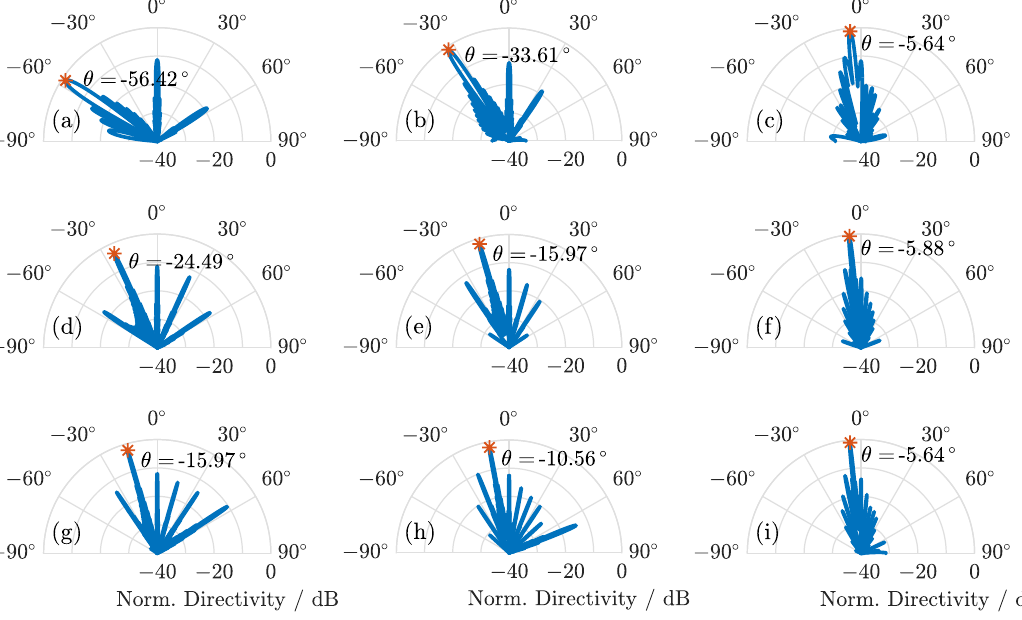
Figure 7. Calculated radiation pattern for ( a ) the maximum steering angle at 0.3THz, ( b ) the middle of the steering range at 0.3THz, and ( c ) the minimum steering angle of the steering range at 0.3THz. Calculated radiation pattern at ( d ) the maximum steering angle at 0.6THz, ( e ) the middle of the steering range at 0.6THz, and ( f ) the minimum steering angle of the steering range at 0.6THz. Calculated radiation pattern at ( g ) the maximum steering angle at 0.9THz, ( h ) the middle of the steering range at 0.9THz, and ( i ) the minimum steering angle of the steering range at